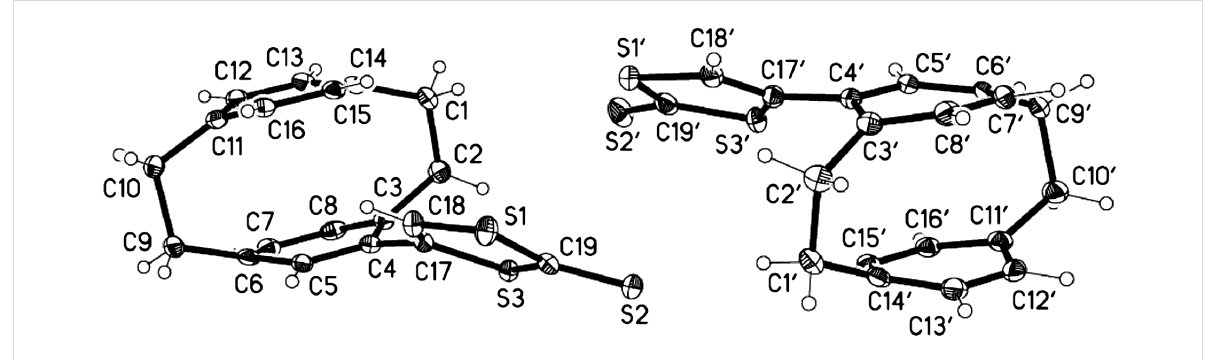
Figure 2: Molecular structure of compound 6 (two independent molecules). Ellipsoids represent 30% probability